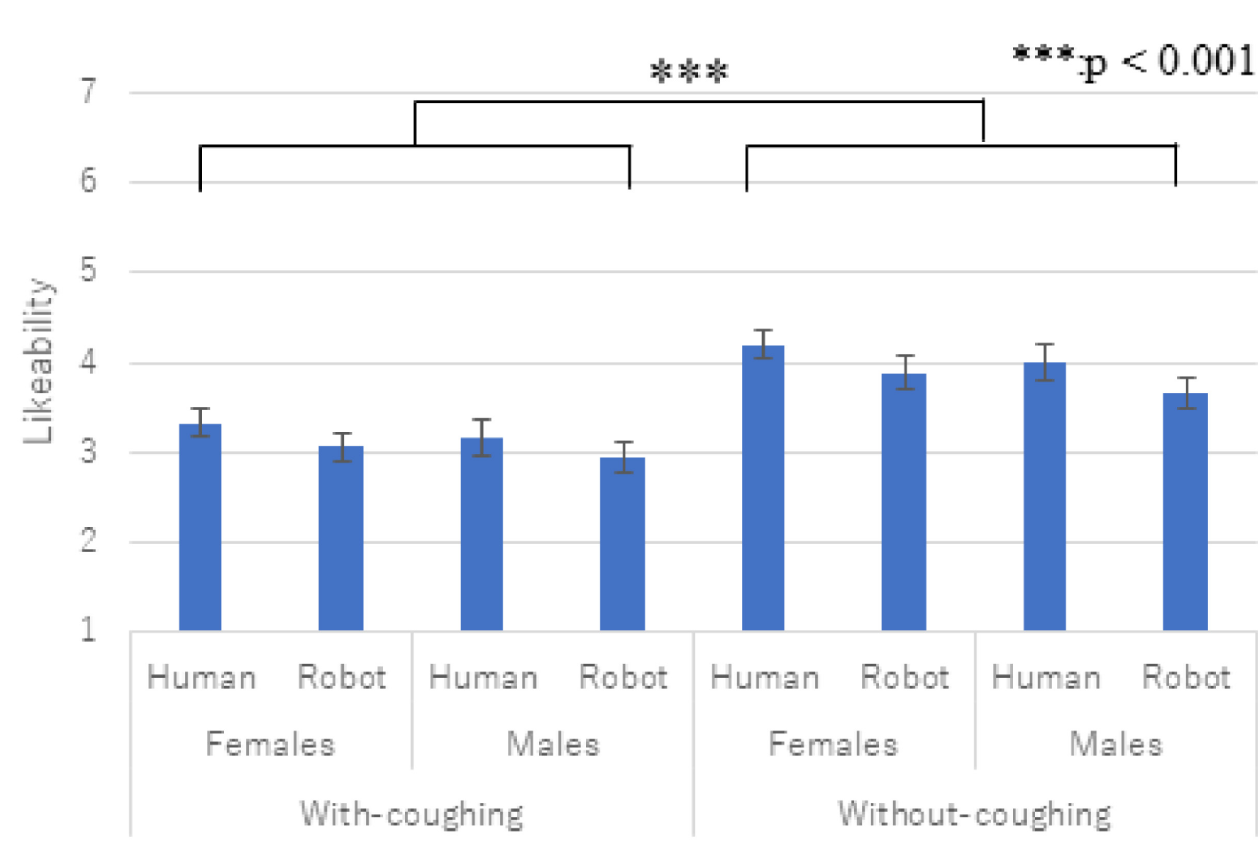
Fig 6. Average and S.E of likeability. The coughing factor showed a significant main